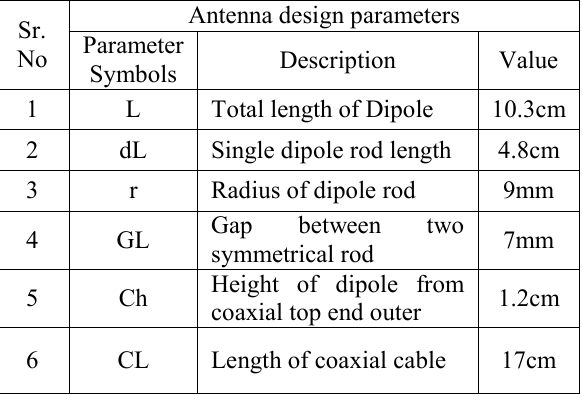
Figure 3: Proposed HFSS module of 3-Axis crossed dipole